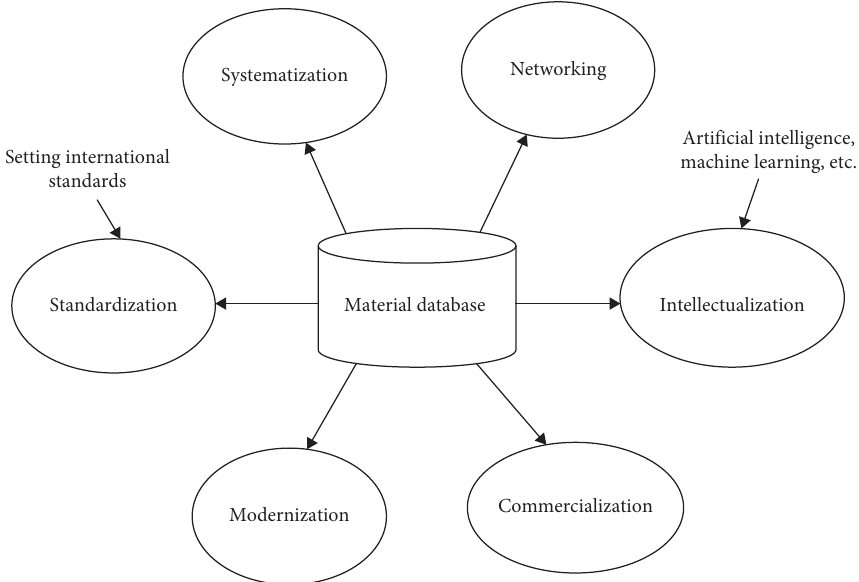
Figure 5: Developing trends of materials